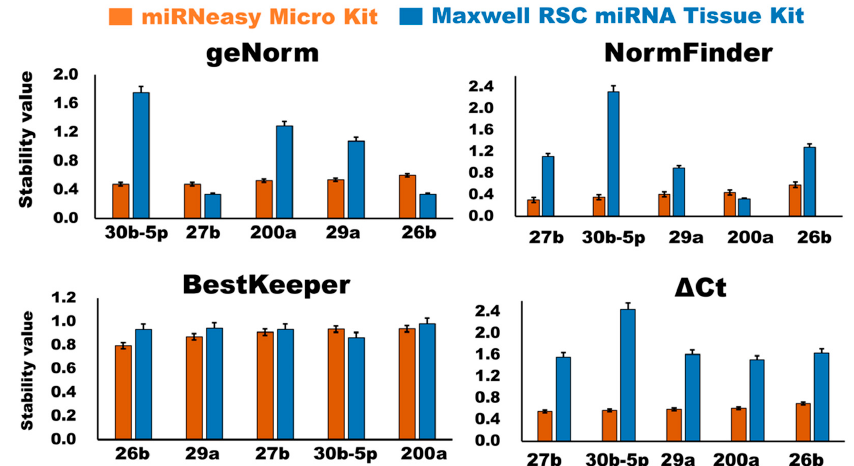
Figure 5. Stability analysis of candidate internal control miRNAs in bovine milk sEVs in accordance with extraction kits, miRNeasy Micro Kit and Maxwell RSC miRNA Tissue Kit by geNorm, NormFinder, BestKeeper, and ∆ Ct. The x - and y -axis indicate the candidate internal control miRNAs and stability value of the miRNAs, respectively.